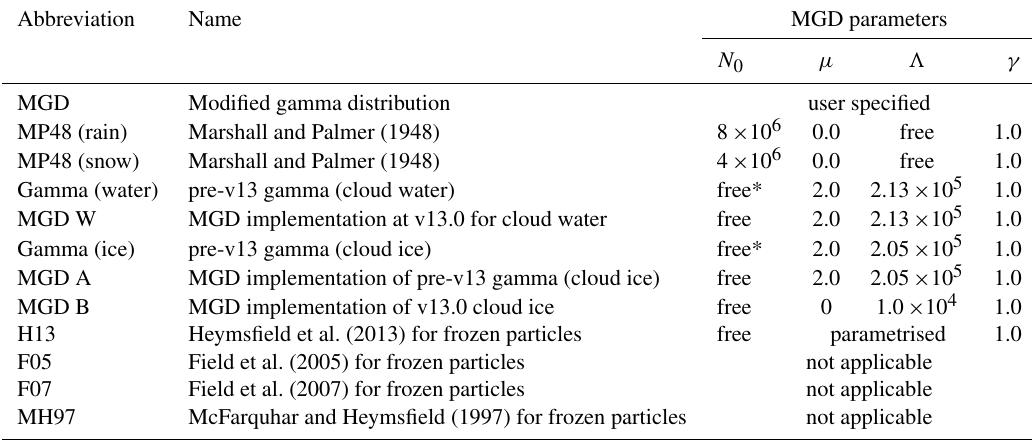
Table 4. Available PSDs. All parameters are in SI